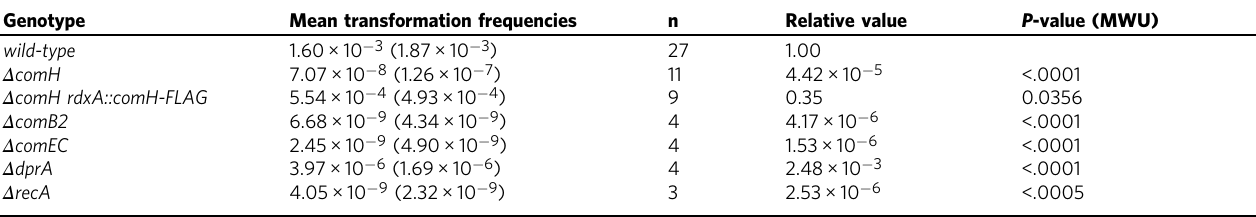
Table 1 Natural transformation frequencies for H. pylori